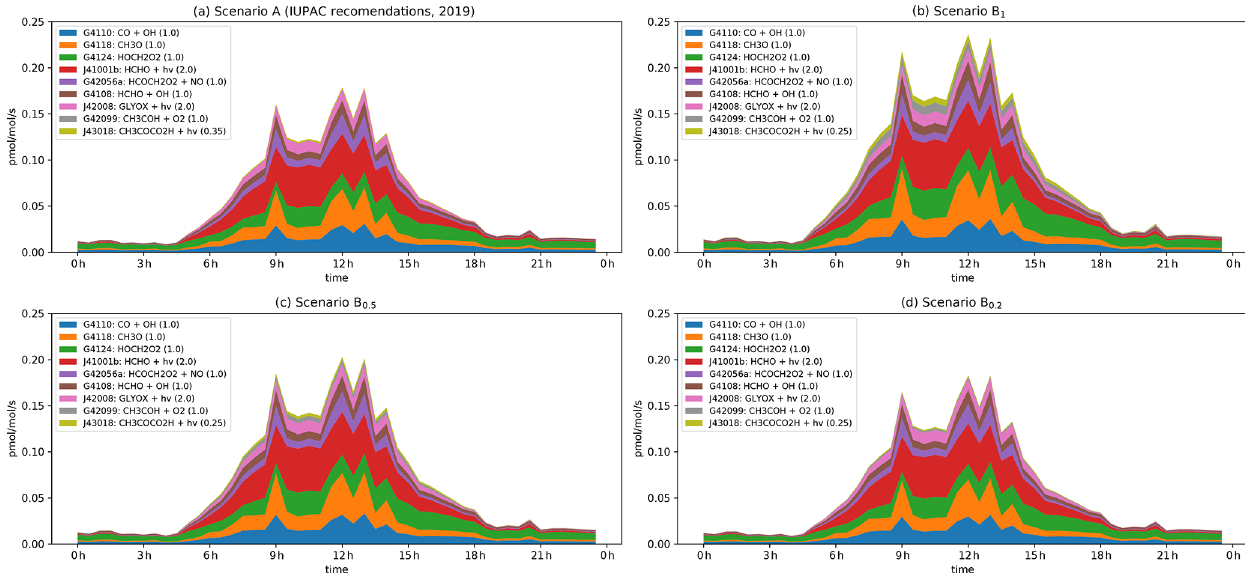
Figure 8. Modelled rates of HO 2 formation (in pptvs − 1 ) through the diel cycle from photolysis of pyruvic acid (blue, orange, and green) and other photochemical processes during IBAIRN. (a) Scenario A (IUPAC). (b) Scenario B 1 . (c) Scenario B 0 . 5 . (d) Scenario B 0 . 2 . In the